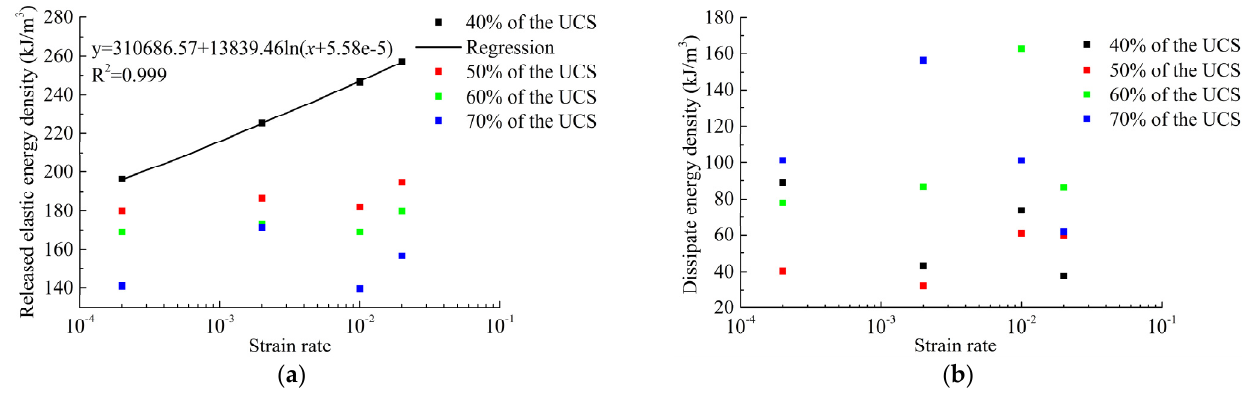
Figure 10. Effect of dynamic loading rate on ( a ) the released elastic energy density and ( b ) the dissipated energy density.